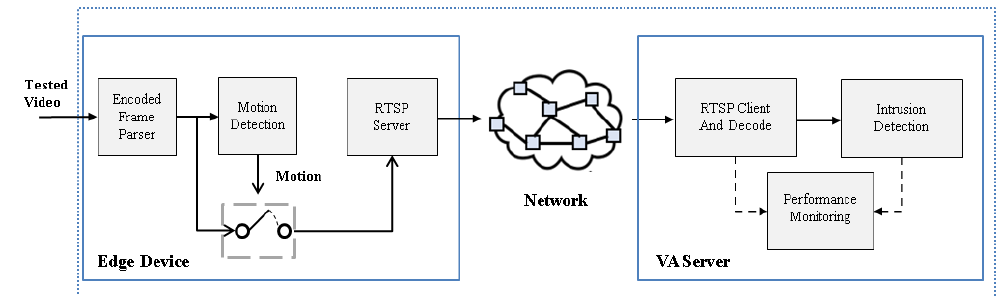
Figure 11. Overview of the system design. RTSP, real-time streaming